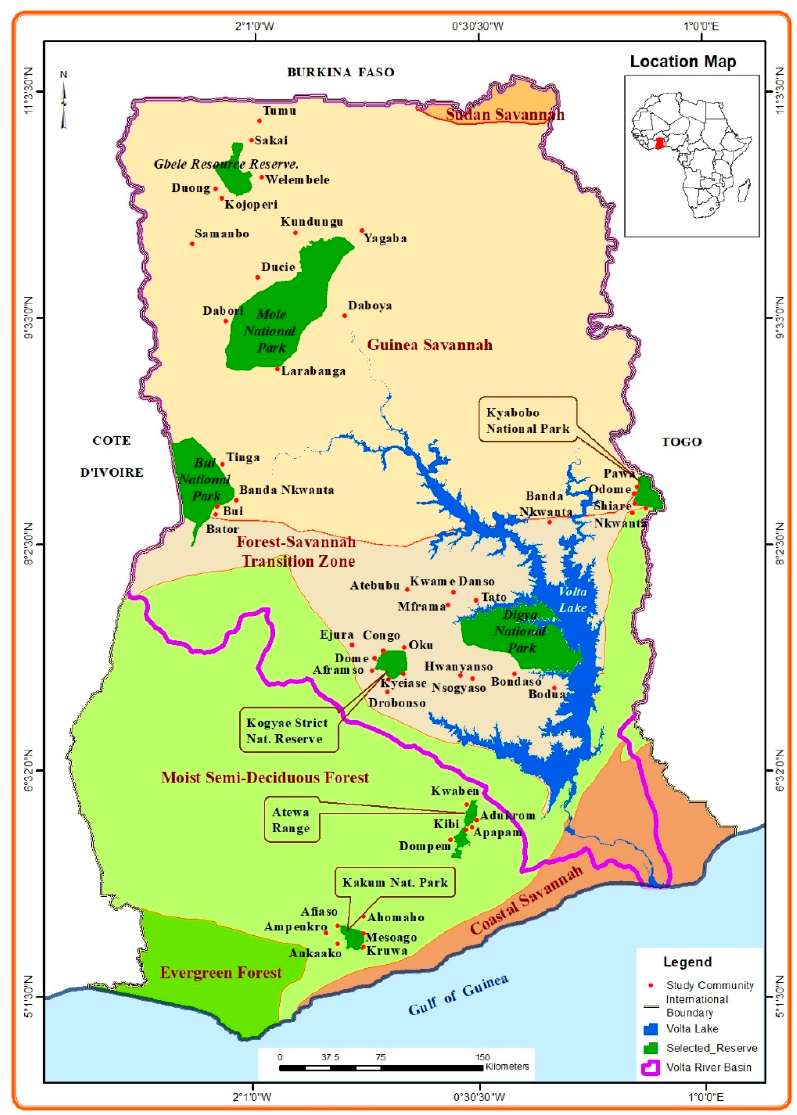
Figure 2. Map of Ghana and the Study Sites.